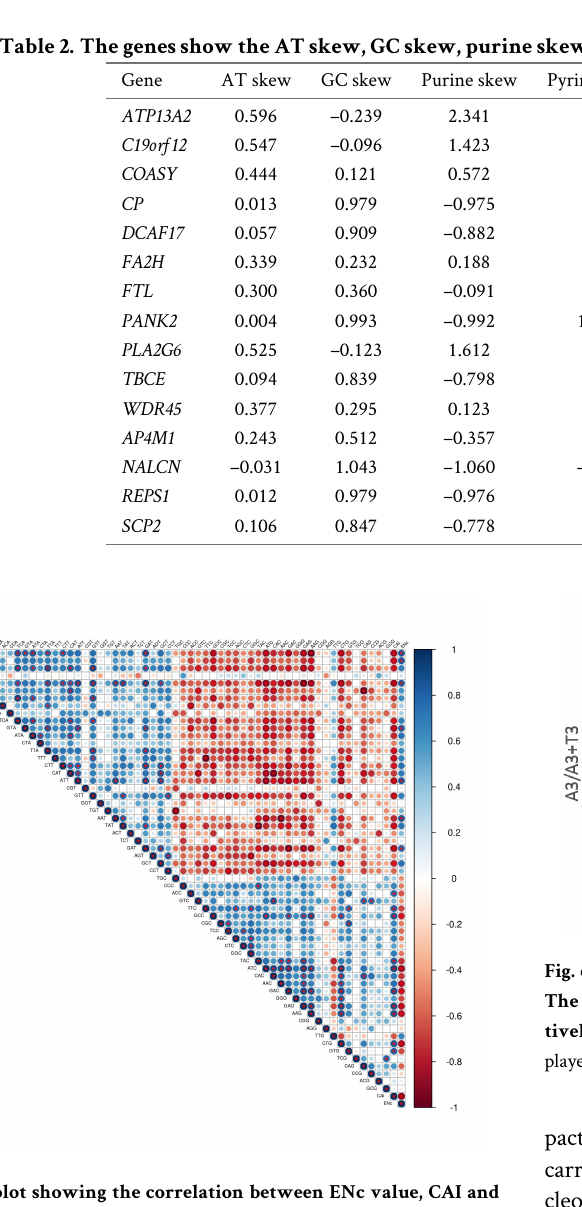
Fig. 5. A plot showing the correlation between ENc value, CAI and RSCU values of codons. Blue circles are showing positive correlation, while red circles are showing negative correlation. Siginificant correlation ( p < 0.05) is shown by red star within the circles.